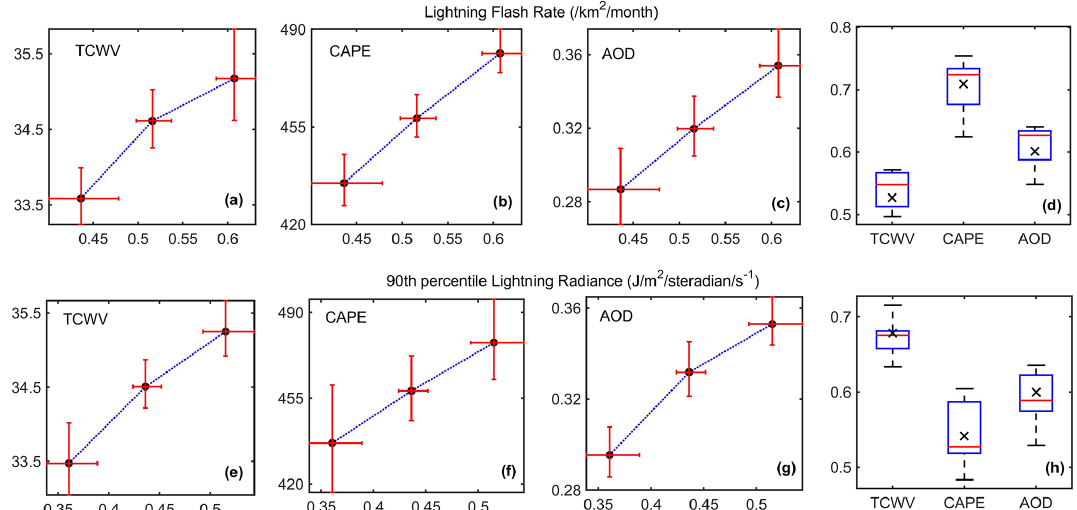
Figure 3. Temporal dominance cluster analysis results of lightning frequency and extreme radiances with respect to (a, e) TCWV, (b, f) CAPE and (c, g) AOD over the entire Indian region; (d, h) the distribution of the correlation coefficient due to zonal clustering for both lightning parameters.